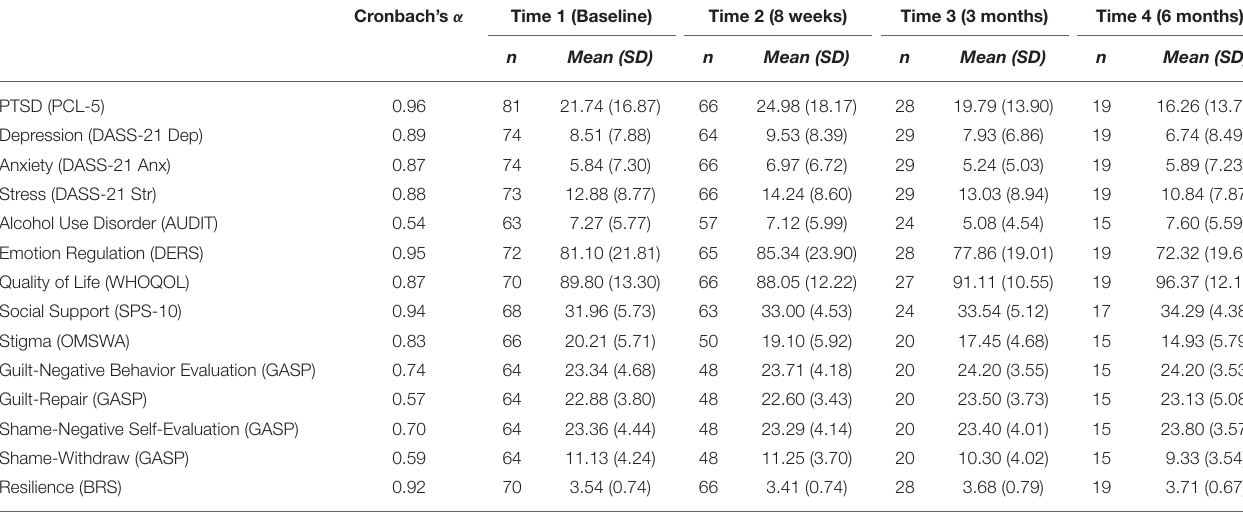
TABLE 2 | Sample size and mean scores on outcome measures at each time